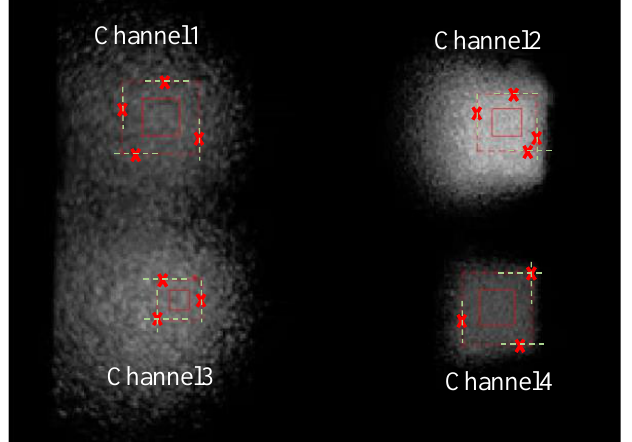
Figure 7. The paradigm of receivers (red rectangles) segmented with corner detection (noted with cross markers) and shrinking (from the dashed rectangles to solid ones) in the image captured by the camera.